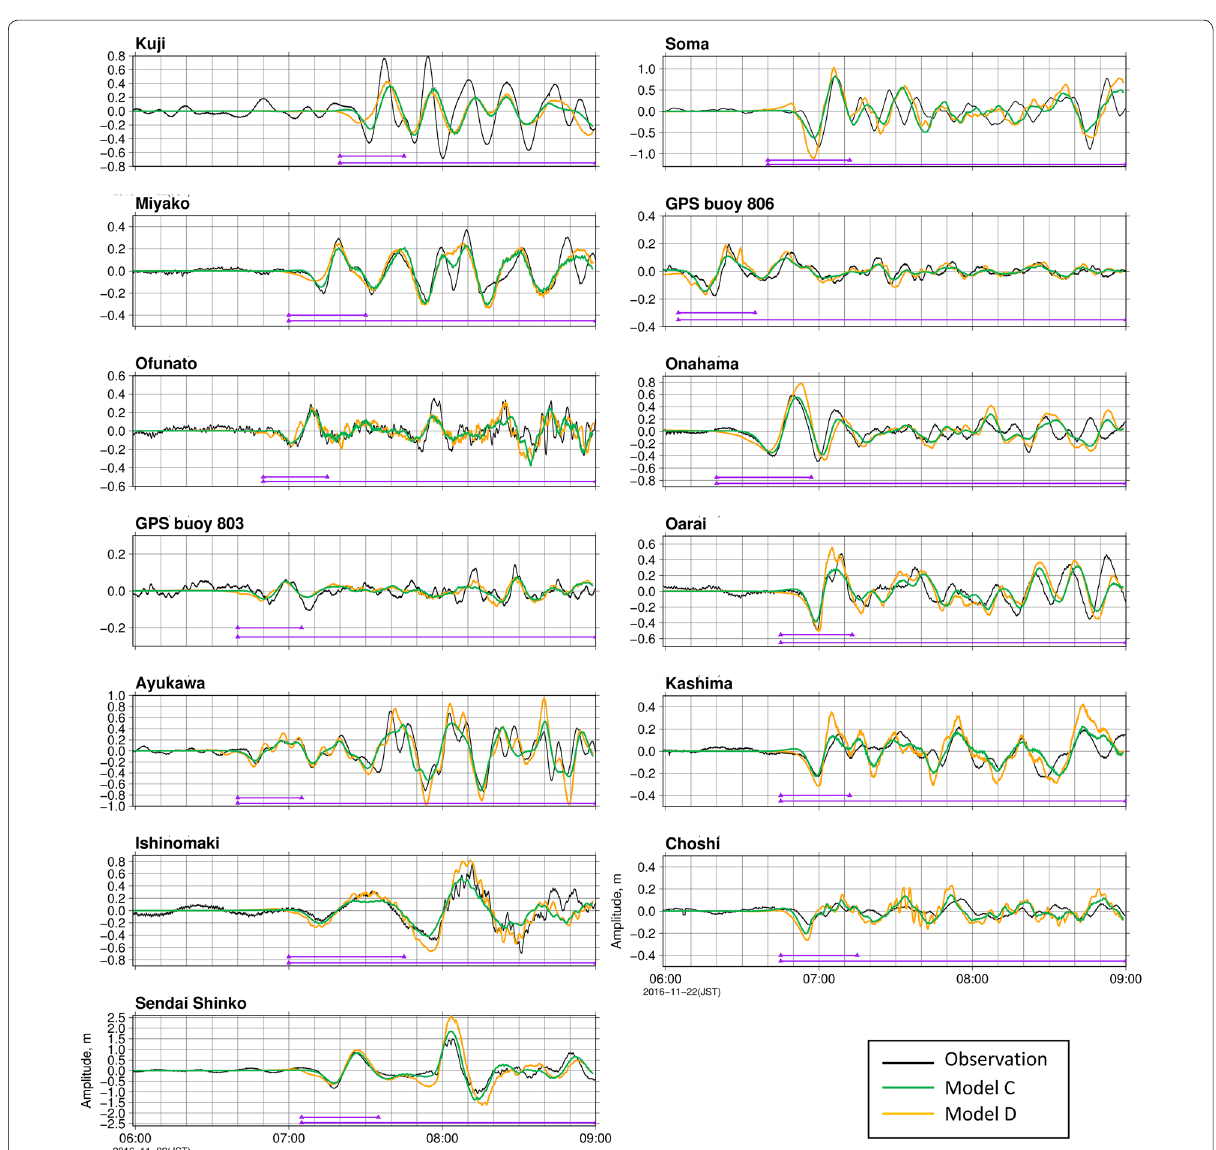
Fig. 7 Comparison of waveforms at 13 stations from observations, model C, and model D. Black curves are the observed waveforms, green curves are waveforms from model C, and orange curves are waveforms from model D. Data lengths for calculating VR1 and VR2 at each station are indicated by purple